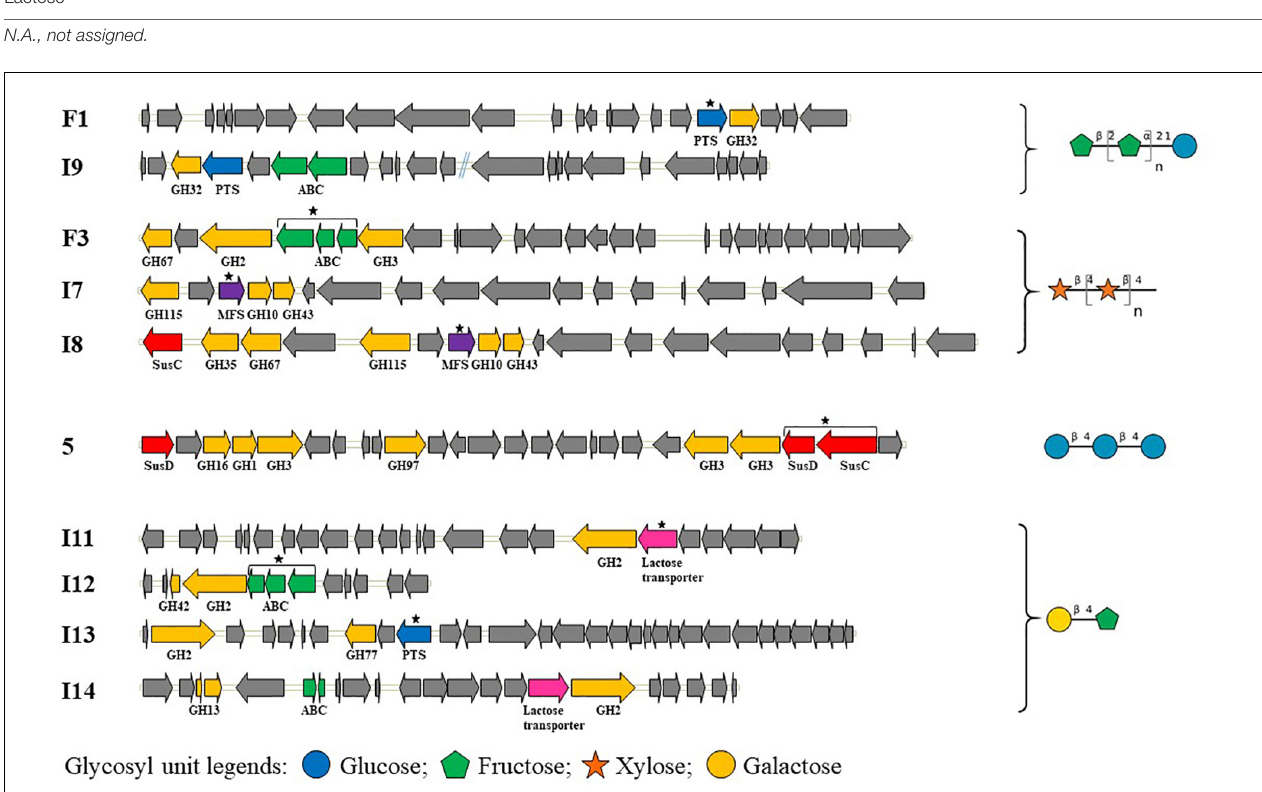
FIGURE 2 | Gene organization of hit clones able to grow on different glycosides. Black stars denote the transporters predicted to be responsible for the clone phenotypes, because they are the only glycoside transport systems detected in the metagenomic PULs or because the SusD component of the SusCD system is missing. The two contigs of clone I9 are separated by blue double lines. Genes are represented by arrows and colored based on their function: genes encoding GHs are shown in yellow, glycoside transporters in blue for PTS, green for ABC, red for SusCD, purple for MFS and pink for “lactose transporter,” and other functions in